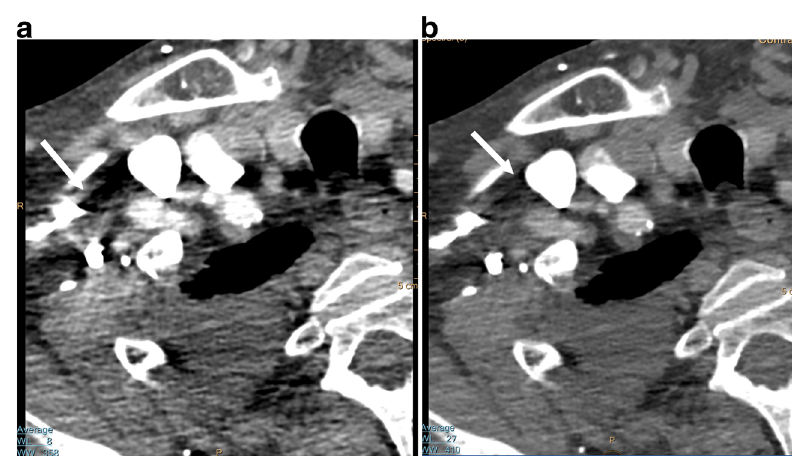
Fig. 7 Beam hardening artefact reduction. ( a ) Axial 120-kVp routine diagnostic image at the level of the right axilla shows beam hardening artefact ( arrow ) originating from dense contrast within the right subclavian vein, which limits evaluation of adjacent structures. ( b ) 100-keV VMI at the same level shows near-total elimination of the beam hardening artefact ( arrow )